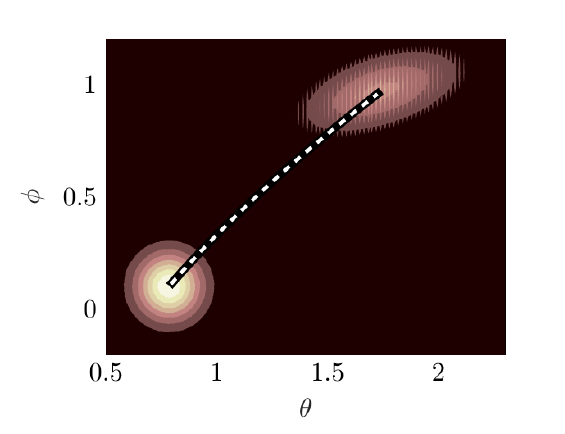
Figure 4. Evolution of the joint pdf from uncorrelated to correlated bivarite wrapped normal